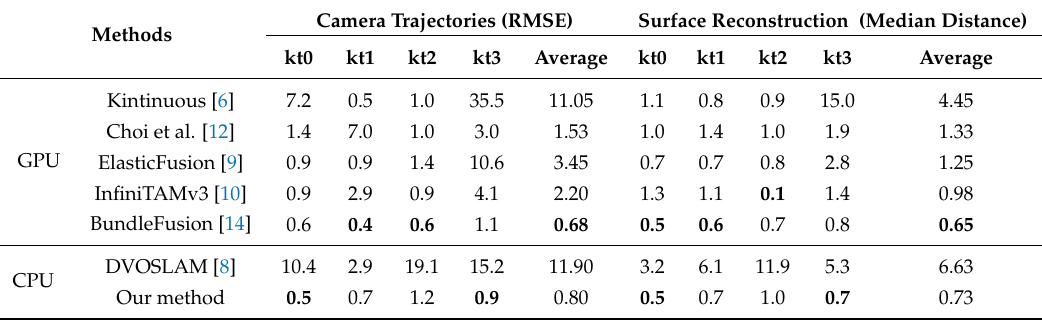
Table 5. Accuracy of the estimated camera trajectories (ATE RMSE in meters) on the Augmented ICL-NUIM dataset [12]. X denotes the tracking lost. Bold shows the best